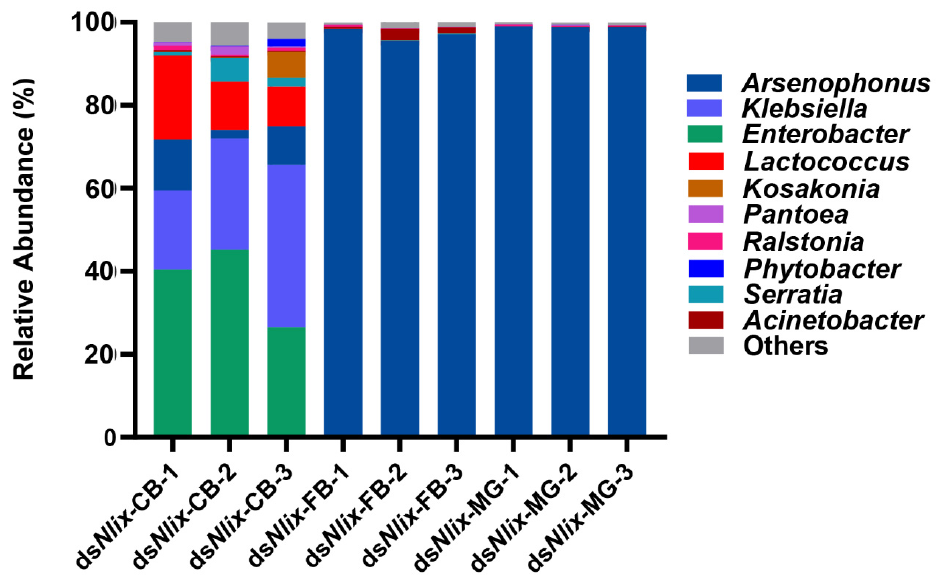
Figure A2. Comparison of the microbiotal structure in CB, FB, and MG of N. lugens after infection of ds Nlix. The 10 species with the highest relative abundances were displayed, and the relative abundances of the remaining species were combined and grouped into Others. CB: copulatory bursa; FB: fat body; MG: midgut.